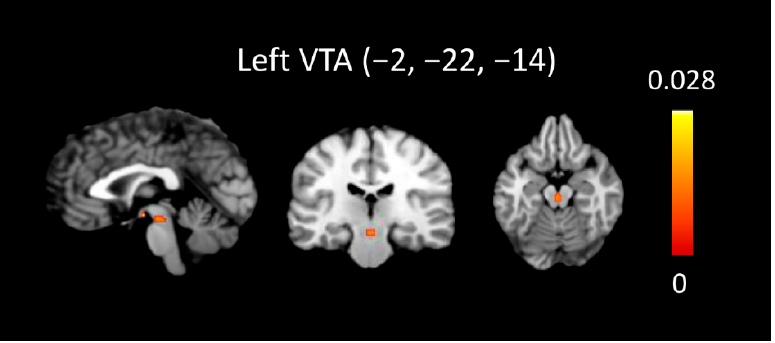
Figure 3. ALE map of conjunction analysis on maternal love with passionate love (FDR pN < 0.01).